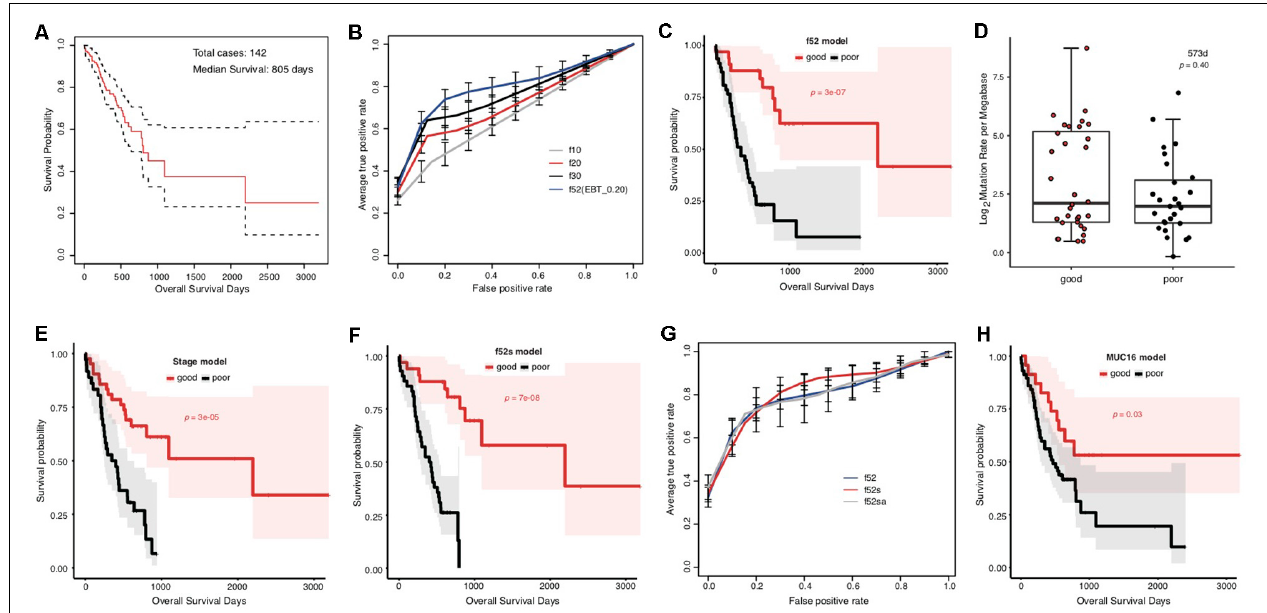
FIGURE 1 | Association between the overall prognosis of TCGA STADs and somatic gene mutations. (A) The Kaplan–Meier overall survival curve of the TCGA STAD cases. The median was indicated with an arrow. The analysis throughout the figure used the median survival as stratification cutoff of STAD prognosis. (B) The 5-fold cross-validated ROC curves of genetic models predicting the prognosis of STADs. (C) The Kaplan–Meier overall survival curves of the TCGA STAD cases classified by f52 with a 5-fold cross-validation strategy. (D) The distribution of TMLs for TCGA cases of good and poor prognosis groups. The p -value of the Wilcoxon rank-sum test was indicated. (E,F) The Kaplan–Meier overall survival curves of the TCGA STAD cases stratified by TNM stage information (E) or the combined f52s model with a 5-fold cross-validation strategy (F) . (G) The 5-fold cross-validated ROC curves of the genetic model f52 and the combined models f52s and f52sa predicting the prognosis of STADs. (H) The Kaplan–Meier overall survival curves of the TCGA STAD cases stratified by presence or absence of MUC16 mutations. Gehan–Breslow–Wilcoxon tests were performed to compare the overall survivals, and the p -values were shown in